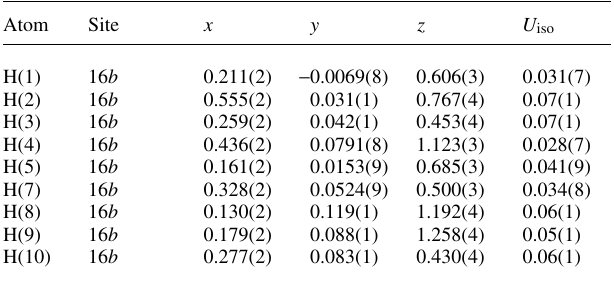
Table 2. Atomic coordinates and displacement parameters (in Å 2 )